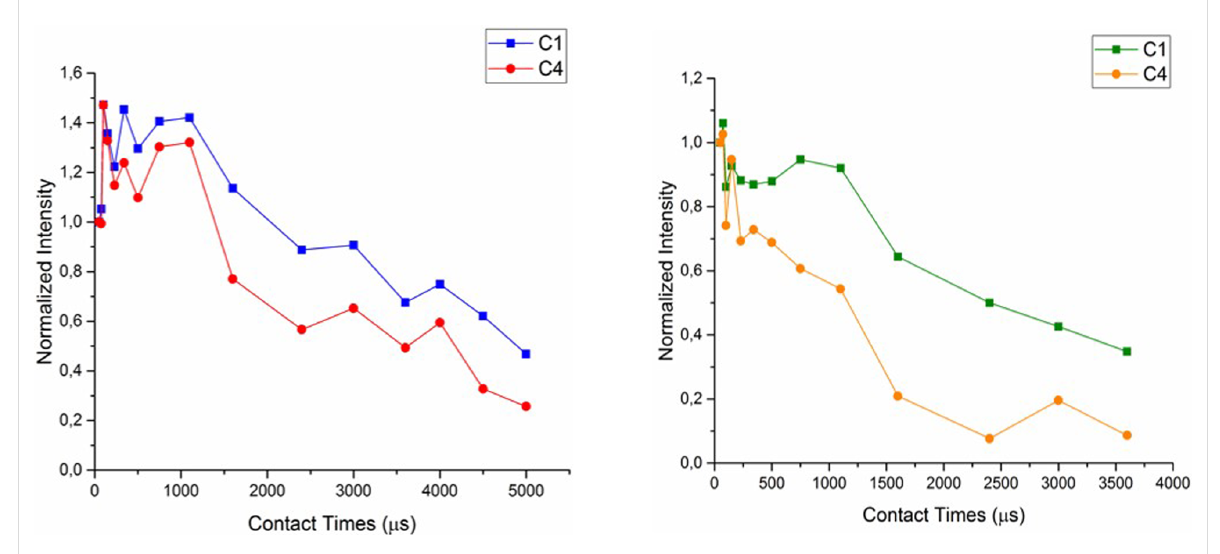
Figure 8: 1 H- 13 C CP oscillatory kinetics for the carbon C(1) and C(4) of CDNS(1:4)-IbuNa sample ( left ) and CDNS(1:8)-IbuNa (right). The notation CDNS-IbuNa indicates the original preparation, irrespective of the conversion of the sodium salt into the undissociated acid.